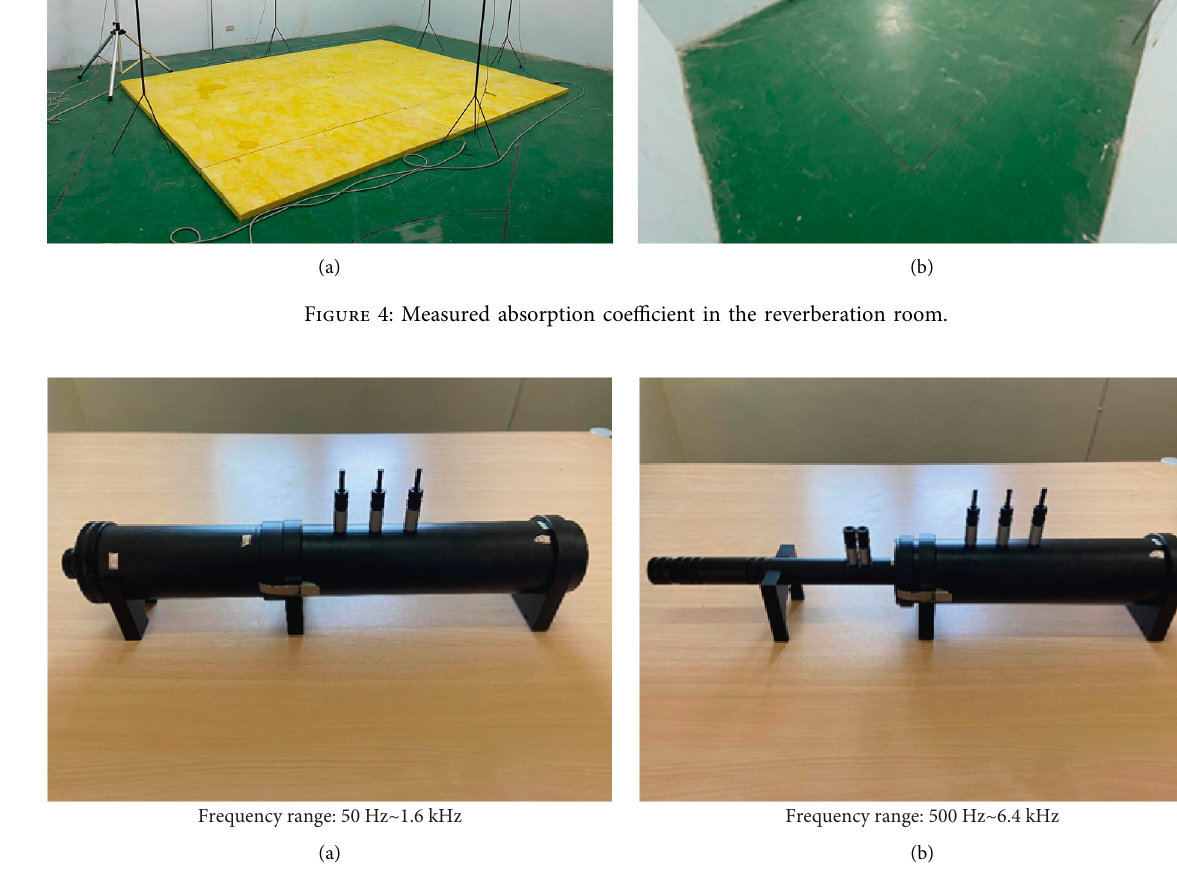
Figure 5: Impedance tube: (a) large and (b) small tube for B&K Type 4206. Table 2: Coding of specimens of glass fiber.